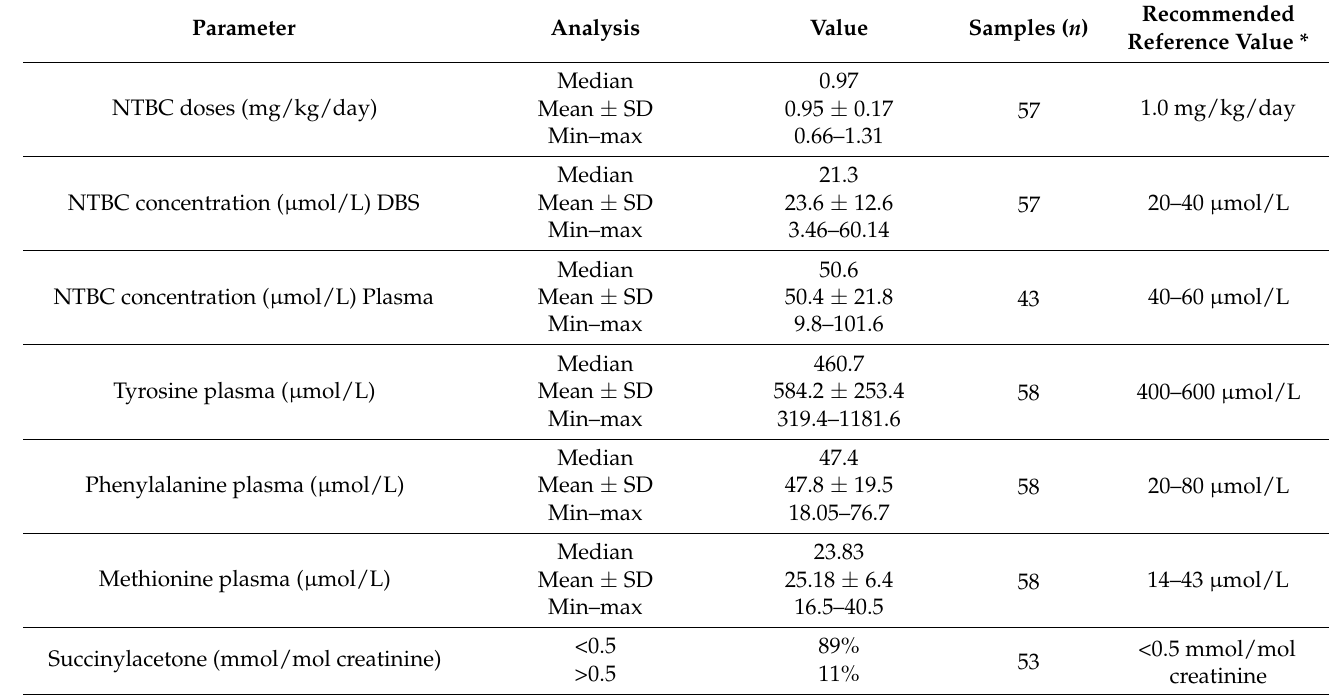
Table 1. Laboratory follow-up parameters for Chilean patients with